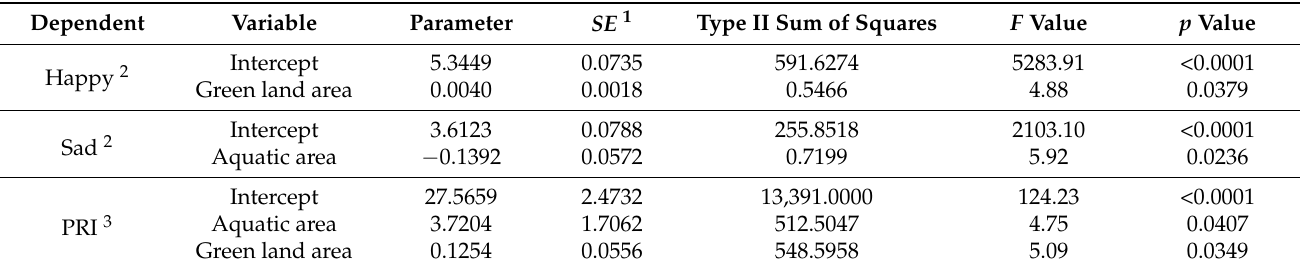
Table 5. Multivariate linear regression of landscape metrics to facial expression scores for visitors in urban forest parks in Northeast China.